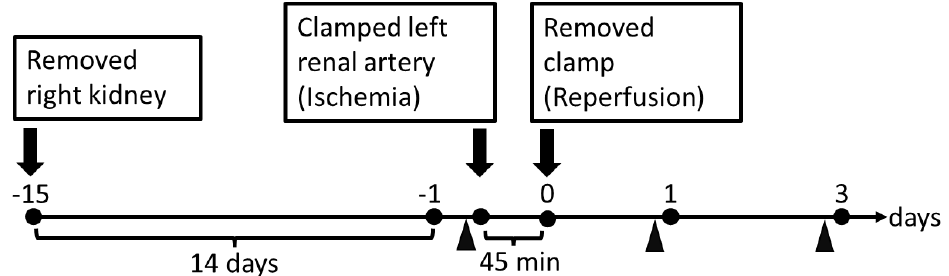
Figure 5. Experimental protocol for IR-induced AKI. Rats were placed in metabolic cages for a 12 h period in order to collect urine samples every day. All urine samples were stored at − 80 °C until use. On Days 1 and 3, the rats were anesthetized with isoflurane to obtain blood and kidney tissues, respectively. Arrowheads indicate urine sampling time points.